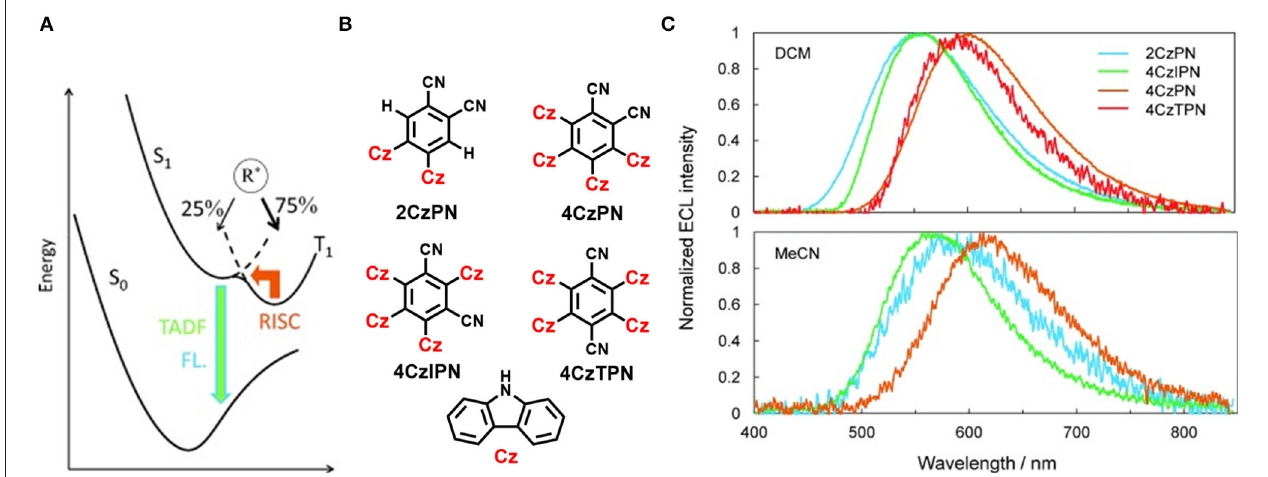
FIGURE 4 | (A) Electronic transitions representation (B,C) Four TADF molecules and their molecular structure normalized electrogenerated chemiluminescence (ECL) spectra of TADF molecules in DCM (top) and MeCN (bottom). Reproduced with permission from Ishimatsu et al. (2014). Copyright © WILEY-VCH Verlag GmbH andamp; Co. KGaA, Weinheim.